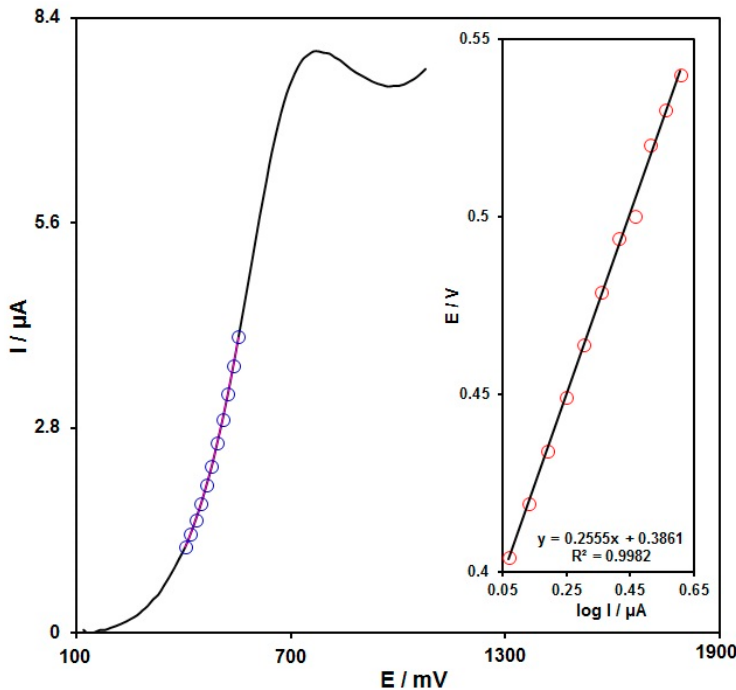
Figure 7. LSV recorded for the PPy NTs/GSPE at 10 mV/s in 0.1 M PBS at pH = 7 with 100.0 µ M hydroxylamine. Points: data used in the Tafel plot. Inset: Tafel plot obtained from the LSV.